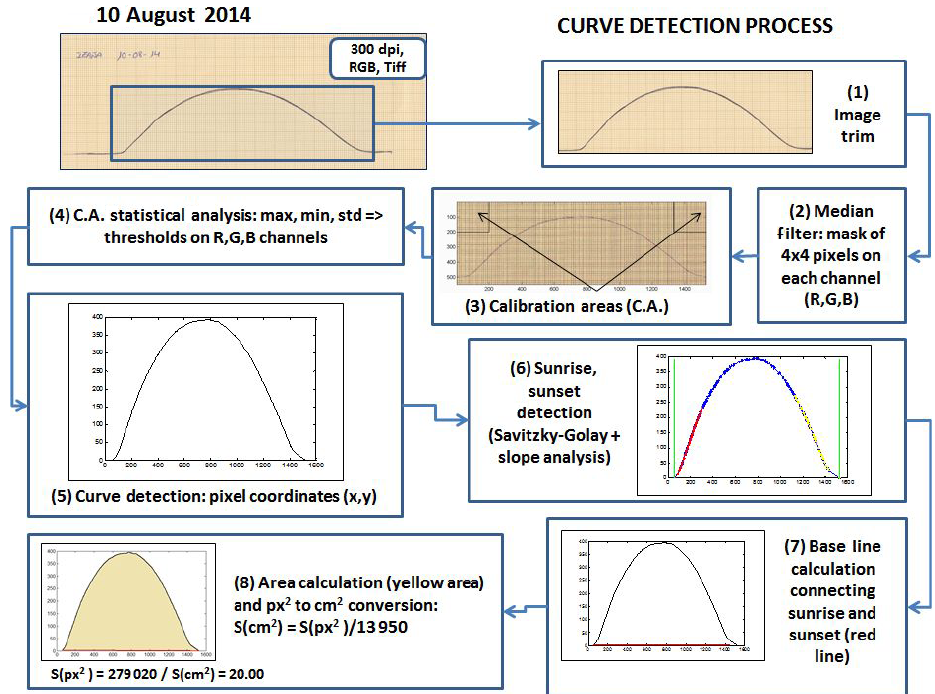
Figure 1. Flow chart of the method used to extract the areas from the strip cards of the bimetallic pyranometer. Table 1. Characteristics and uncertainties of each solar radiation instrument used: Robitzsch bimetallic pyranometer (PYR), Campbell– Stokes sunshine recorder (CS recorder), Kipp & Zonen sunshine duration sensor (CSD recorder), multifilter rotating shadowband